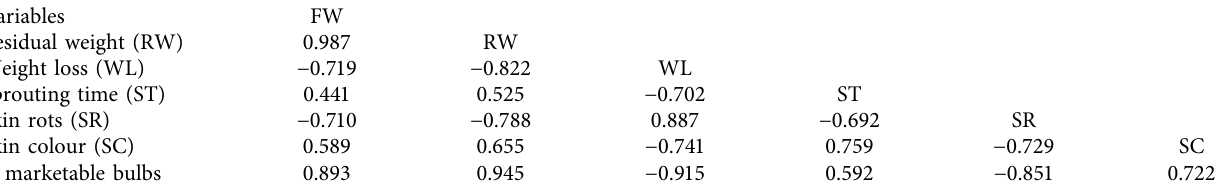
Table 7: Pearson correlation between keeping and visual quality of stored